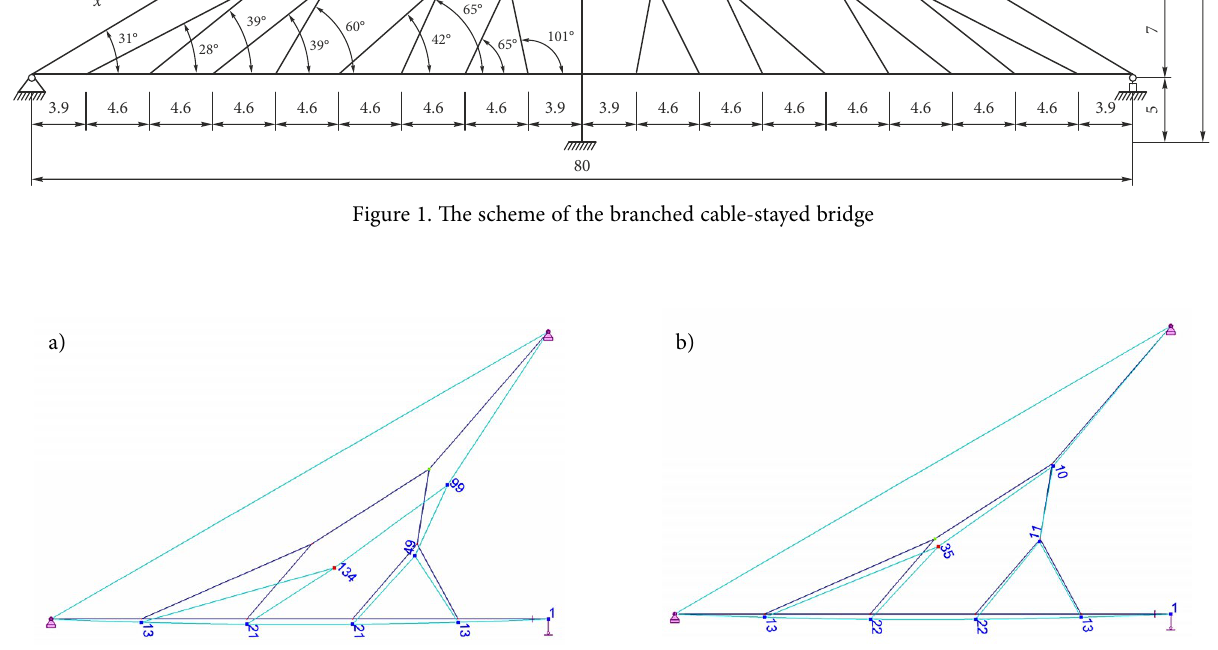
Figure 2. a) − system displacements without the balance of axial forces in the cable connections; b) − system displacements with the balance of axial forces in the cable